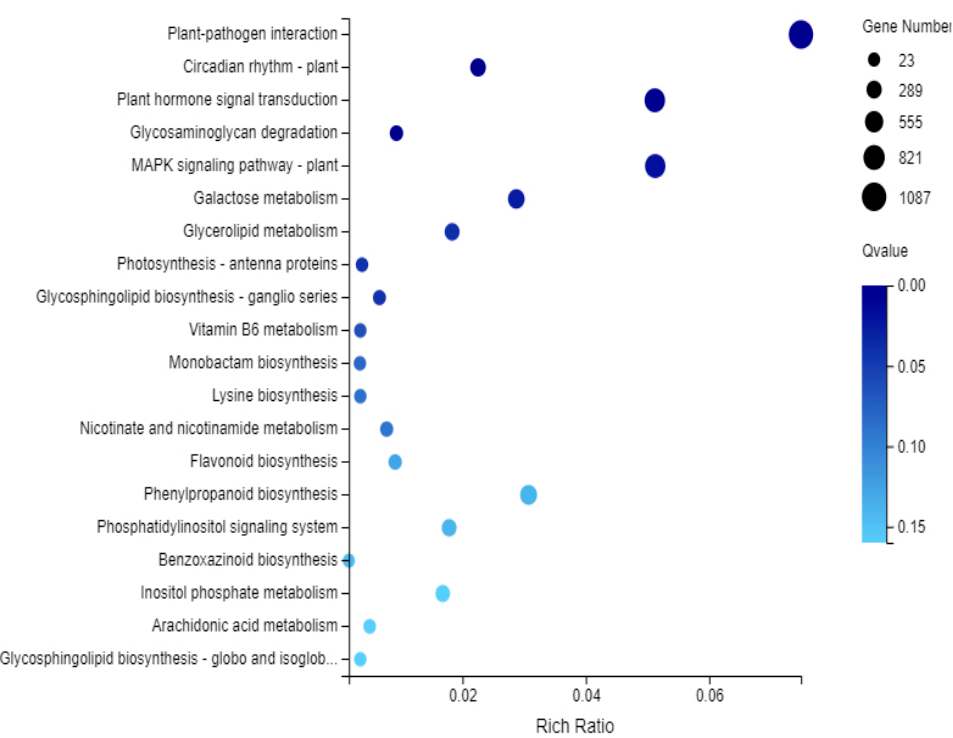
Figure 7. Enrichment bubble pattern of KEGG in differential gene.The horizontal axis of the bubble map of differential enriched KEGG Pathway shows the enrichment ratio, and the vertical axis shows the GO Term. The bubble size represents the number of differential enriched genes annotated to a certain KEGG Term, and the color represents the enriched Qvalue, and the darker the color represents the smaller the Qvalue.